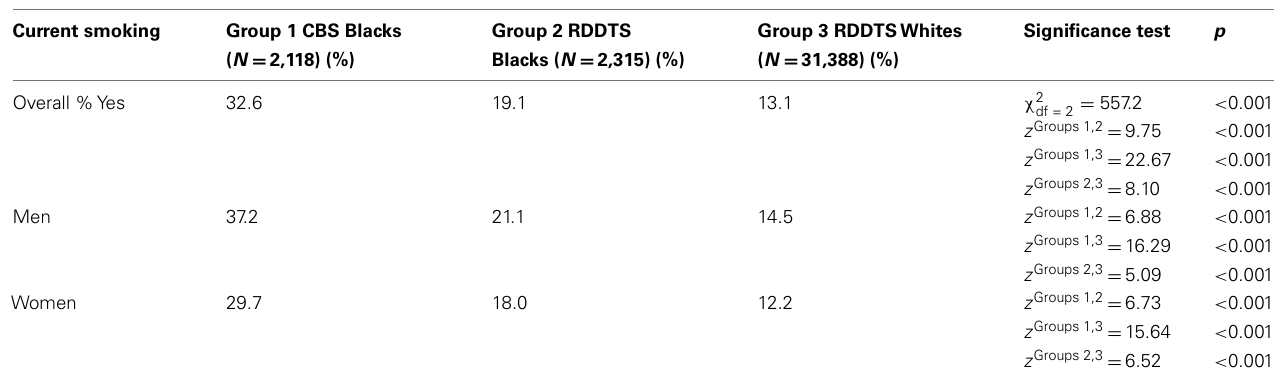
Table 4 | Smoking among CBS blacks vs. RDDTS Blacks